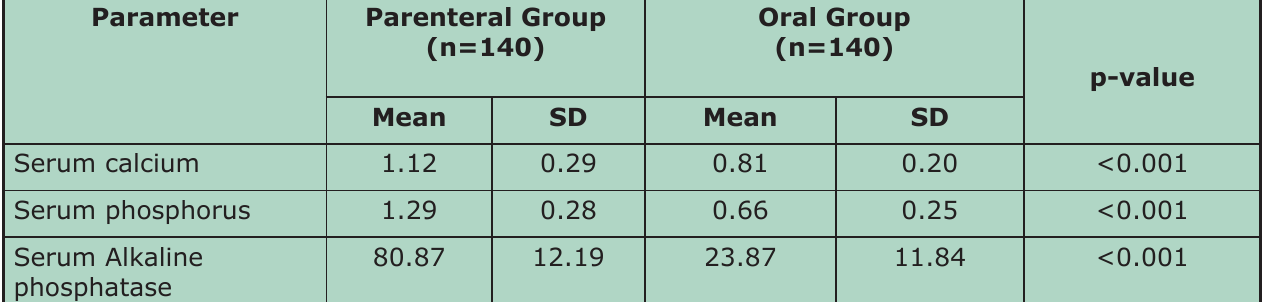
Tehseen S, Mehmood T, et Table-VI: Age: 3 years.